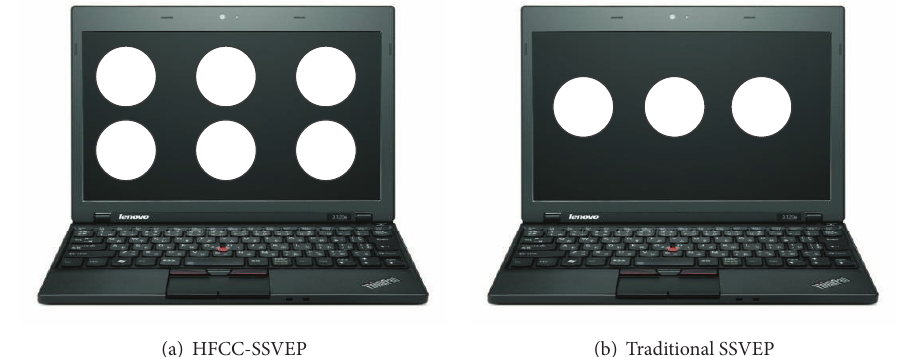
Figure 13: Experimental comparison of HFCC-SSVEP and traditional